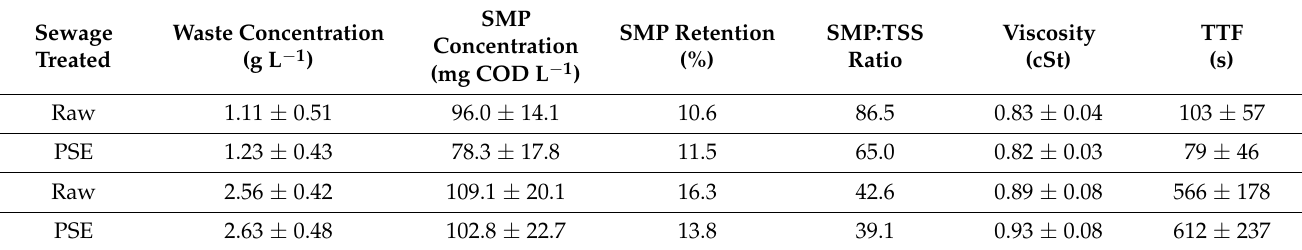
Table 4. SMP concentration, viscosity and filterability of the treated sludge during the ultrafiltration membrane